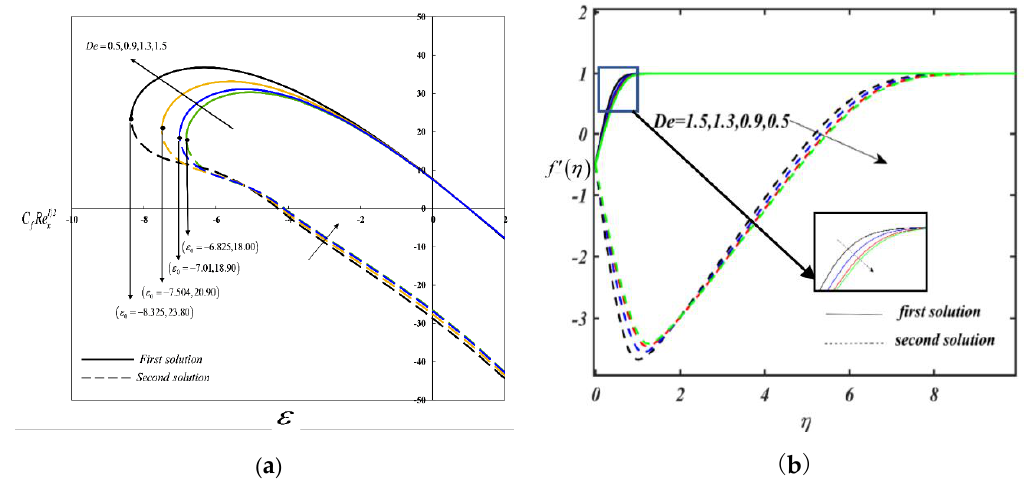
Figure 3. Impact of the Deborah number ( De ) on: ( a ) the reduced skin friction coefficient; ( b ) velocity profiles as De varies when Rd = 1.2, m 0 = 1.5,Pr = 4.36, s = 7, M = 0.5, and φ = 0.02.